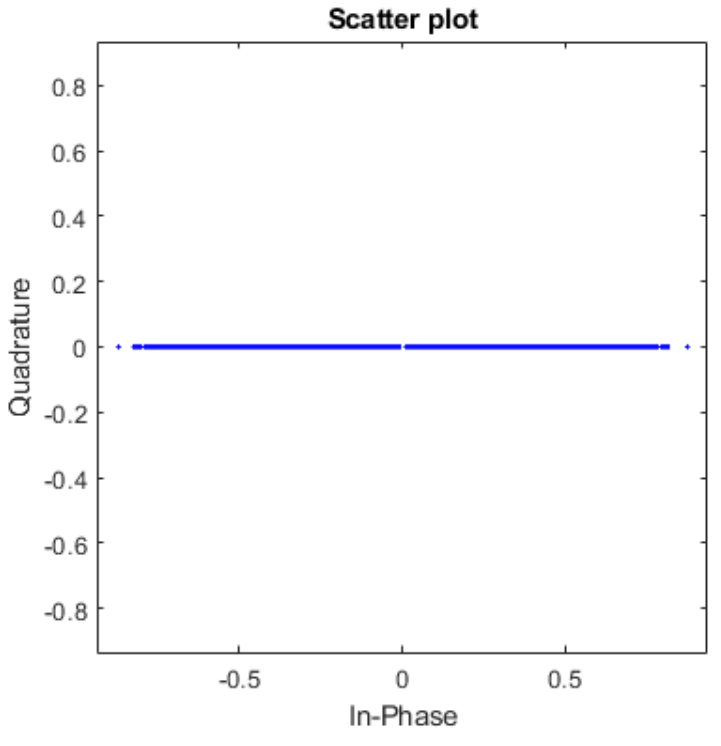
Figure 7. Scatter plot of received symbols without symbol timing